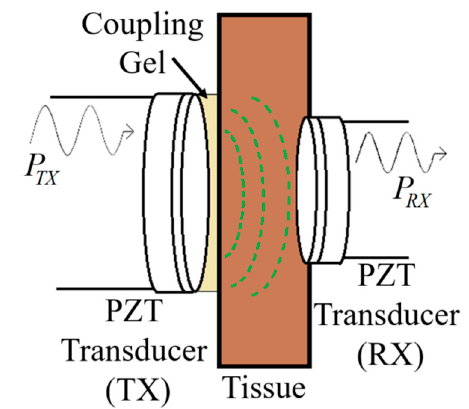
Figure 40. Typical acoustic power transfer (APT) link.